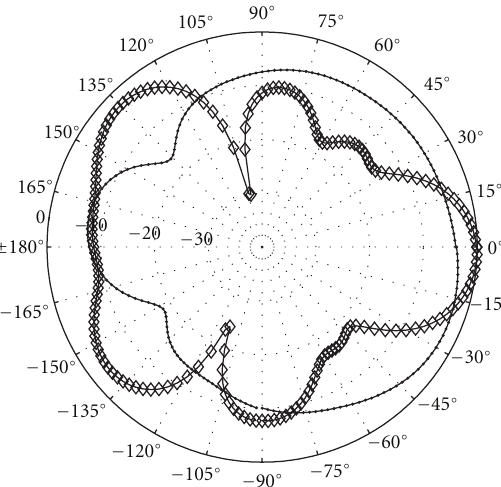
Figure 7: Normalized simulated directivity patterns for the V- shaped antenna array without ground plane—dotted markers for switched mode and diamond markers for phased mode.